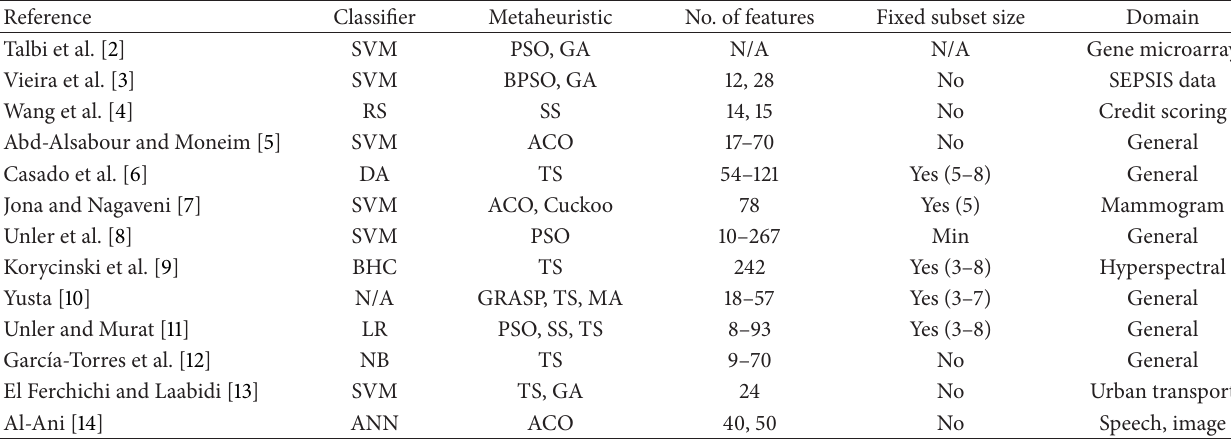
Table 1: A brief survey on feature selection